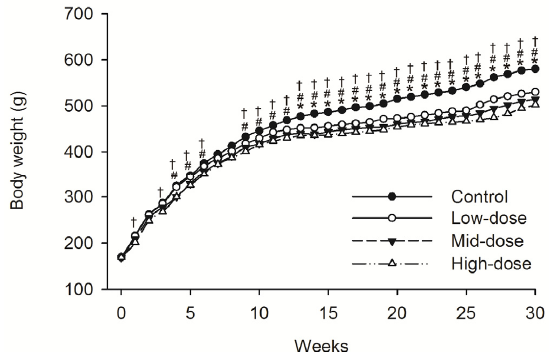
Figure 1. Mean body weight trend chart of male SD rats treated with STE. * p < 0.05 vs. Low-dose group. # p < 0.05 vs. Mid-dosegroup. † p < 0.05 vs. High-dosegroup. Note: C = control group (distilled water), L = low-dose group (STE 3.75 mg/kg), M = mid-dose group (STE 7.50 mg/kg), H = high-dose group (STE 15.00 mg/kg).